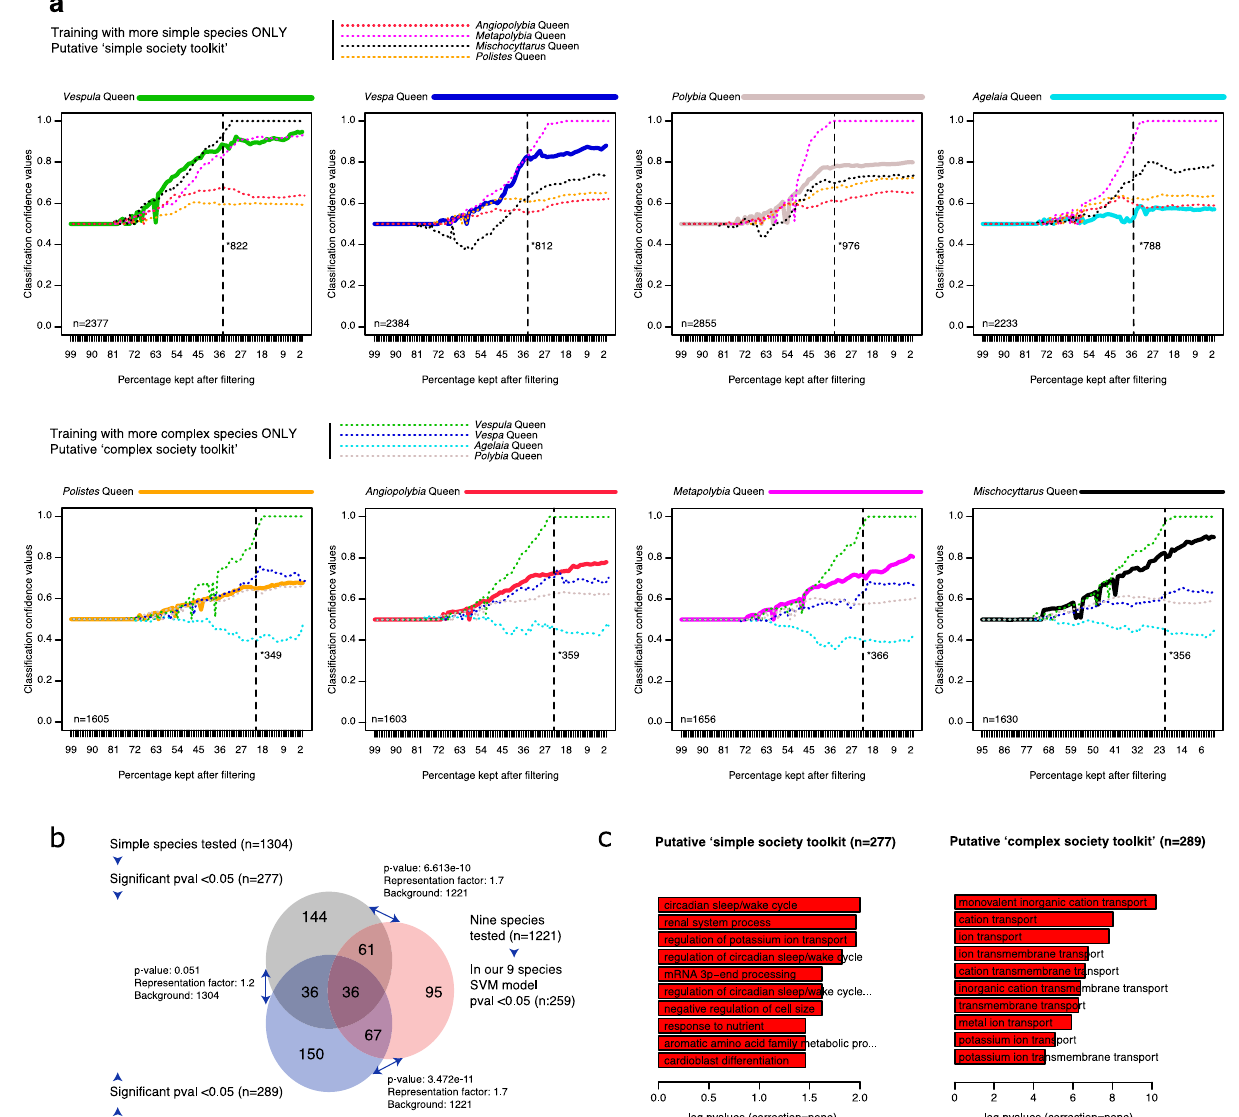
Fig. 5 | Testing for the presence of a distinct ‘ simple society toolkit ’ and a ‘ complexsocietytoolkit ’ .a Usingeitherthefourspecieswiththesimplerormore complex societies, we trained SVM models with information as to which sample represents the queen and worker for the four species. We used a progressive fi l- tering of genes (based on linear regression; the same method used in Fig. 4), to assesshowwellwecouldpredictcasteusingmoreinformativegenes.UPPERpanel: of orthologous genes used in each SVM model are shown (bottom left of each panel); the total number of these genes that were signi fi cant predictors of caste ( p value<0.05)islistedatthedottedline.Foreachtest(pairofQueen/Workerineach